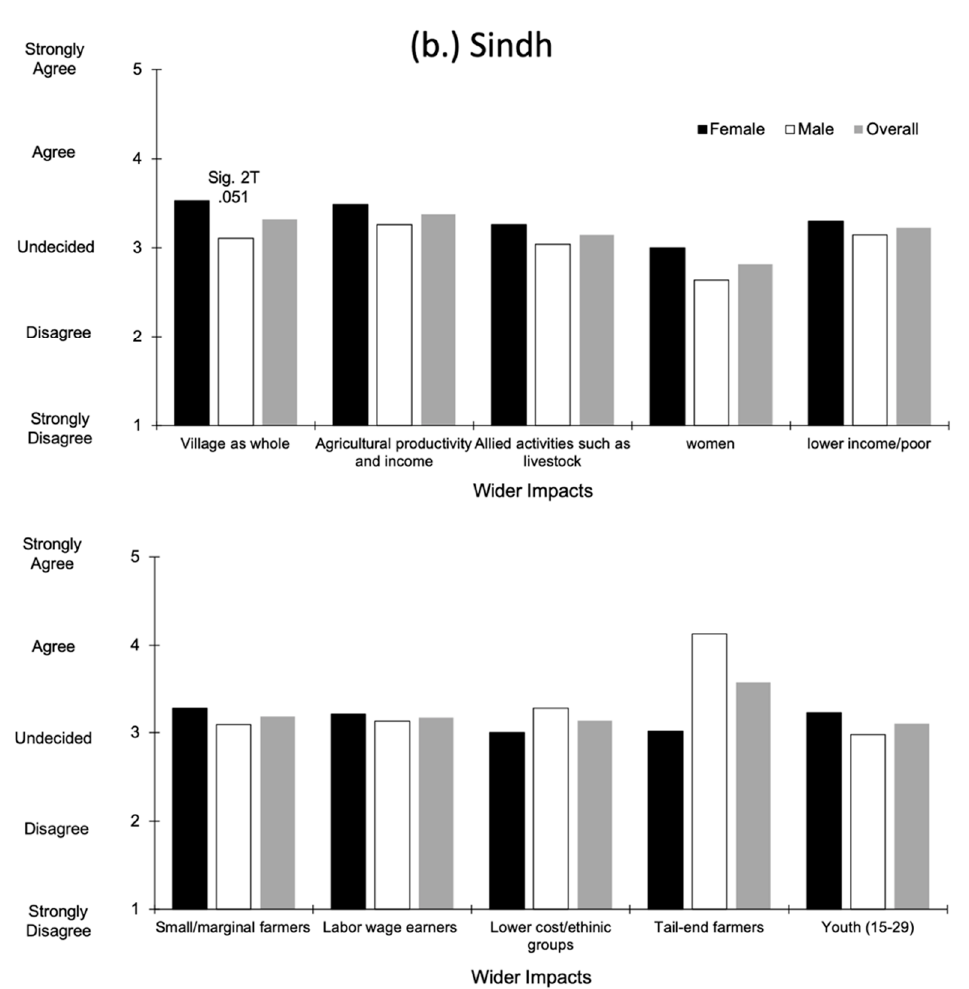
Figure 9. Comparative assessment of wider impacts of PIM (b. Sindh).